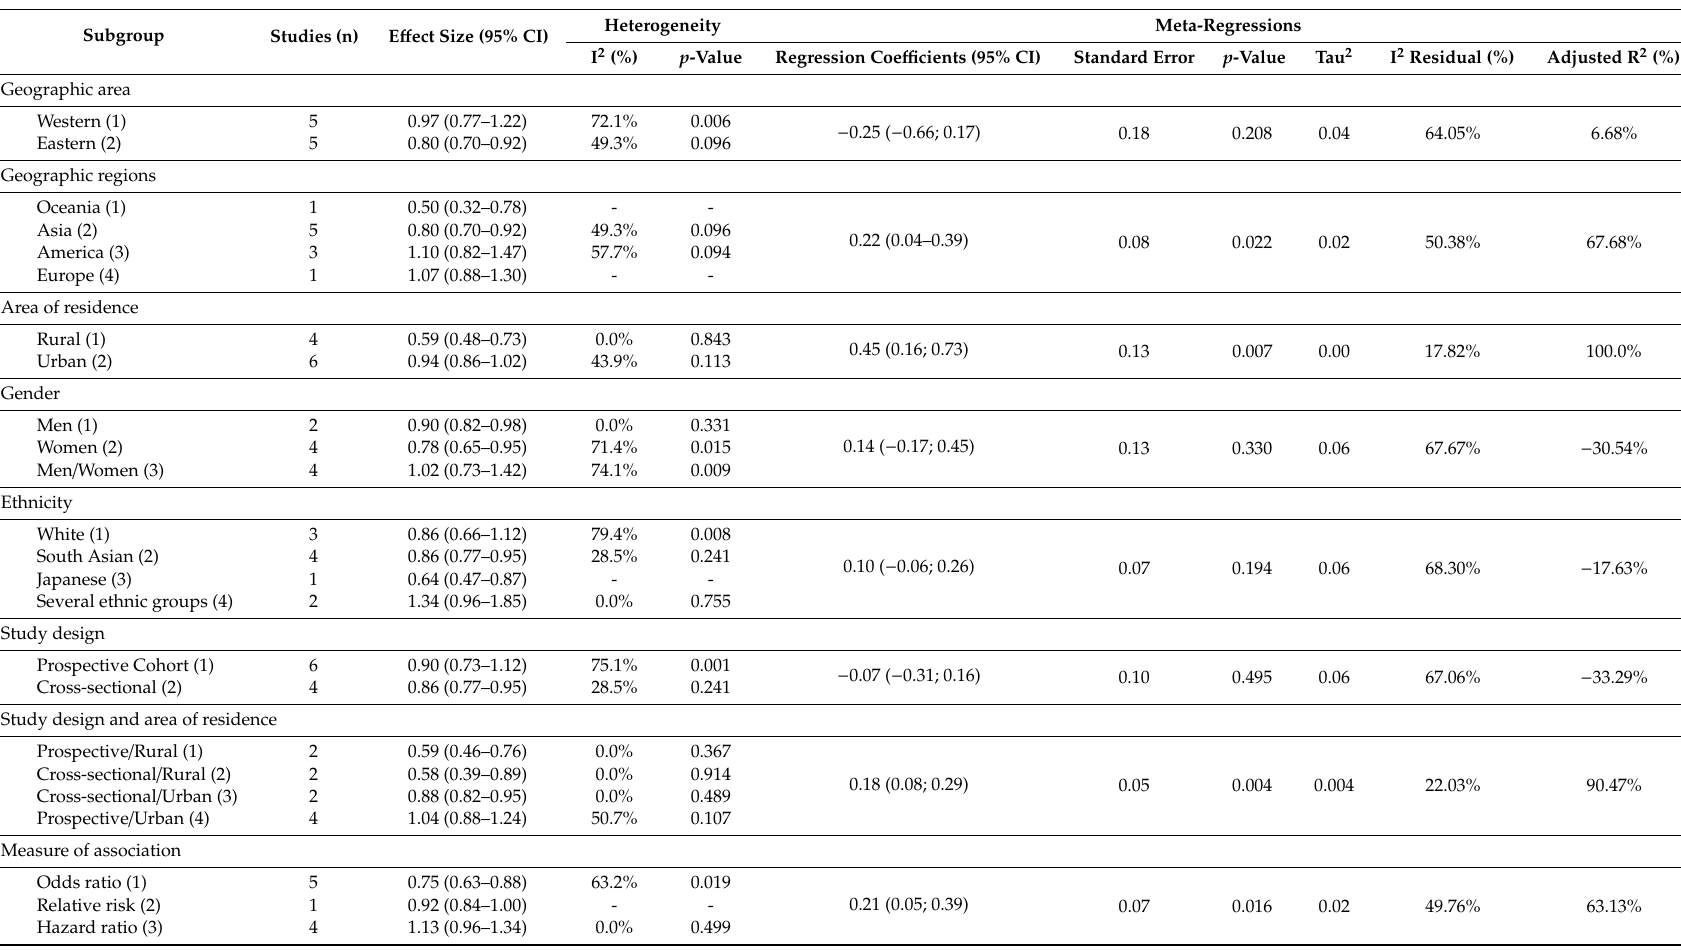
Table 4. Stratified meta-analyses and meta-regressions on the association between dietary zinc intake and risk of type 2 diabetes mellitus.